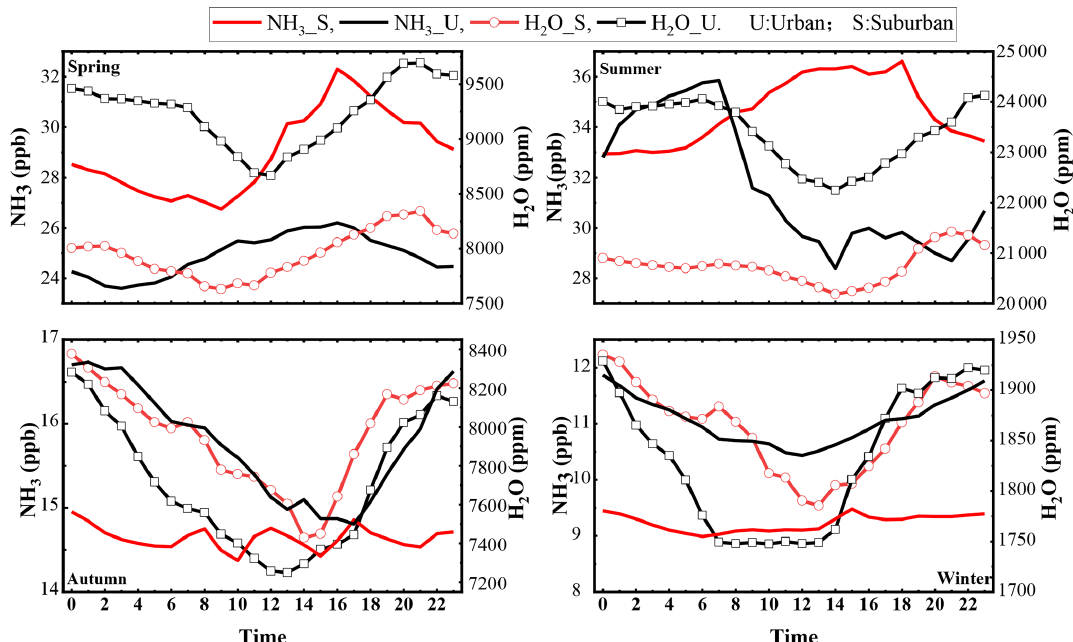
Figure 4. Average diurnal variations in the NH 3 and H 2 O mixing ratios in different seasons at the urban and suburban sites in